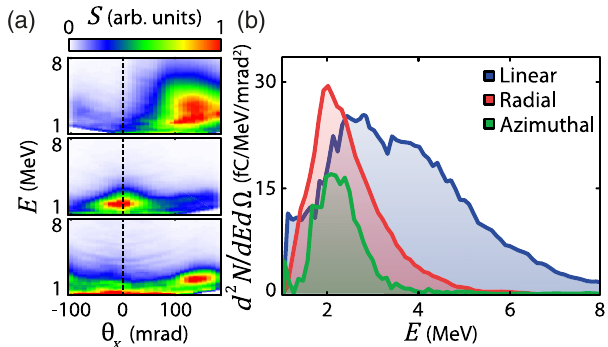
FIG. 2. (a) Angularly resolved energy spectra of the electrons emitted near the incidence plane ( θ y ¼ 0 ) for linear polarization (top panel), radial polarization (middle panel), and azimuthal polarization (bottom panel). The dashed line marks the specular direction. In these images, a value of 1 on the color bar corresponds to 22 fC = MeV = mrad 2 for the top panel, 28 fC = MeV = mrad 2 for the middle panel, and 12 fC = MeV = mrad 2 for the bottom panel. (b) Electron energy spectra obtained at the position of the square markers in Figs. 1(c) – 1(f) for linear polarization (blue curve), radial polarization (red curve), and azimuthal polarization (green